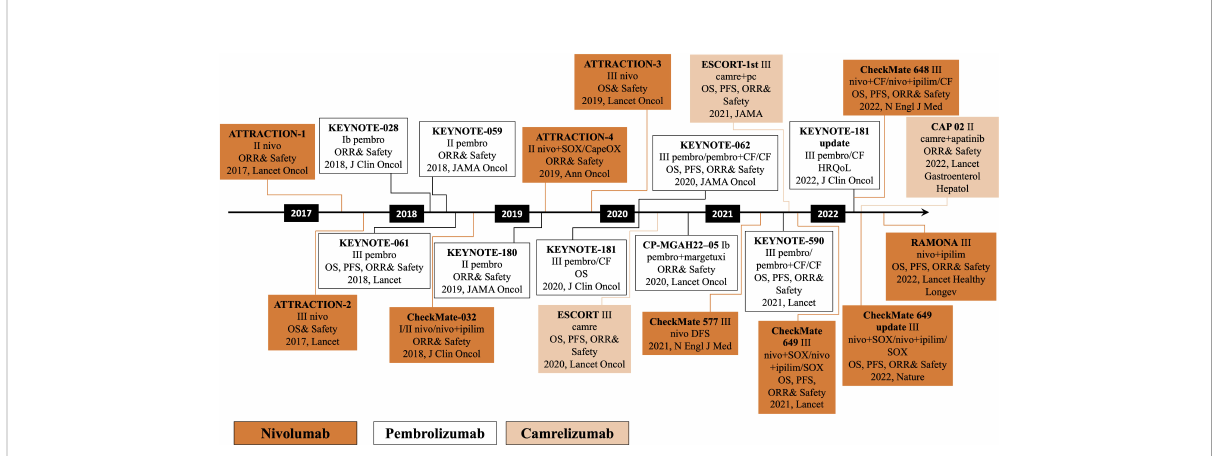
FIGURE 1 Development of chemoradiotherapy combined with immunotherapy in esophageal cancer. pembro, pembrolizumab; nivo, nivolizumab; camre, camrelizumab; ipilim, ipilimumab; OS, overall survival; PFS, progression-free survival; ORR, objective response rate; DFS, disease-free survival; health-related quality-of-life, HRQoL; S-1 plus oxaliplatin, SOX; capecitabine plus oxaliplatin, CapeOX; paclitaxel plus cisplatin,